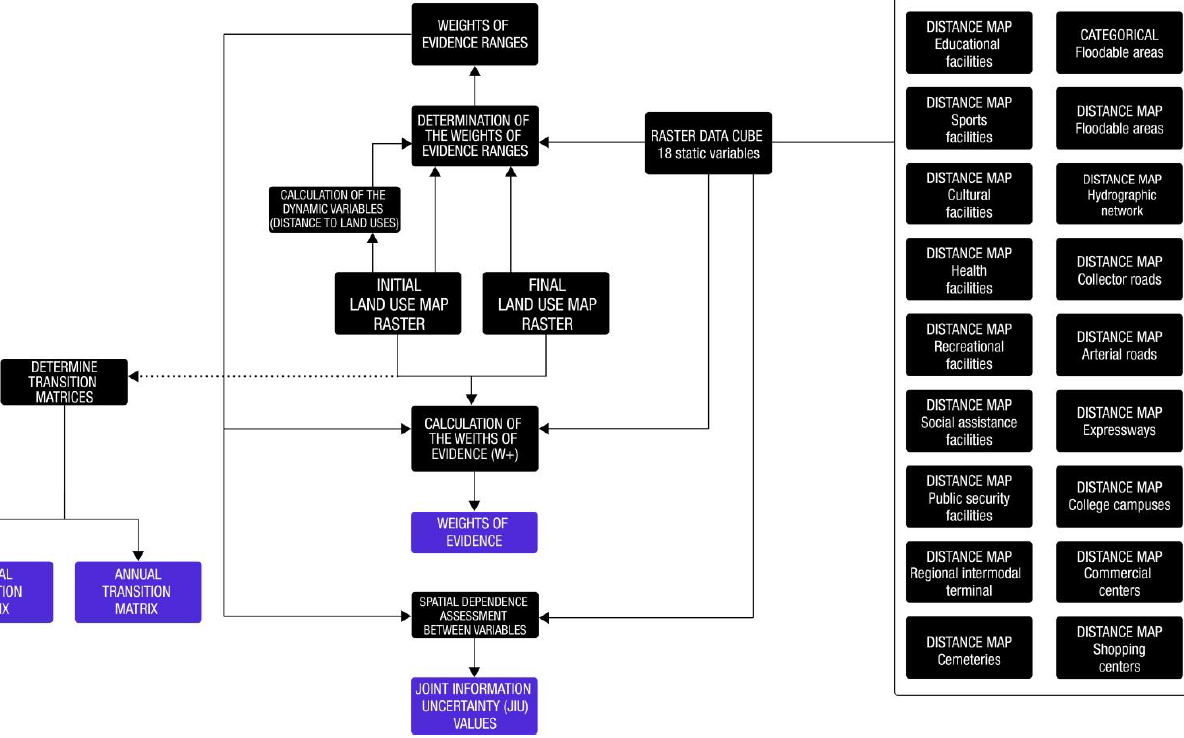
Figure 7. Flowchart of the parameterization step.